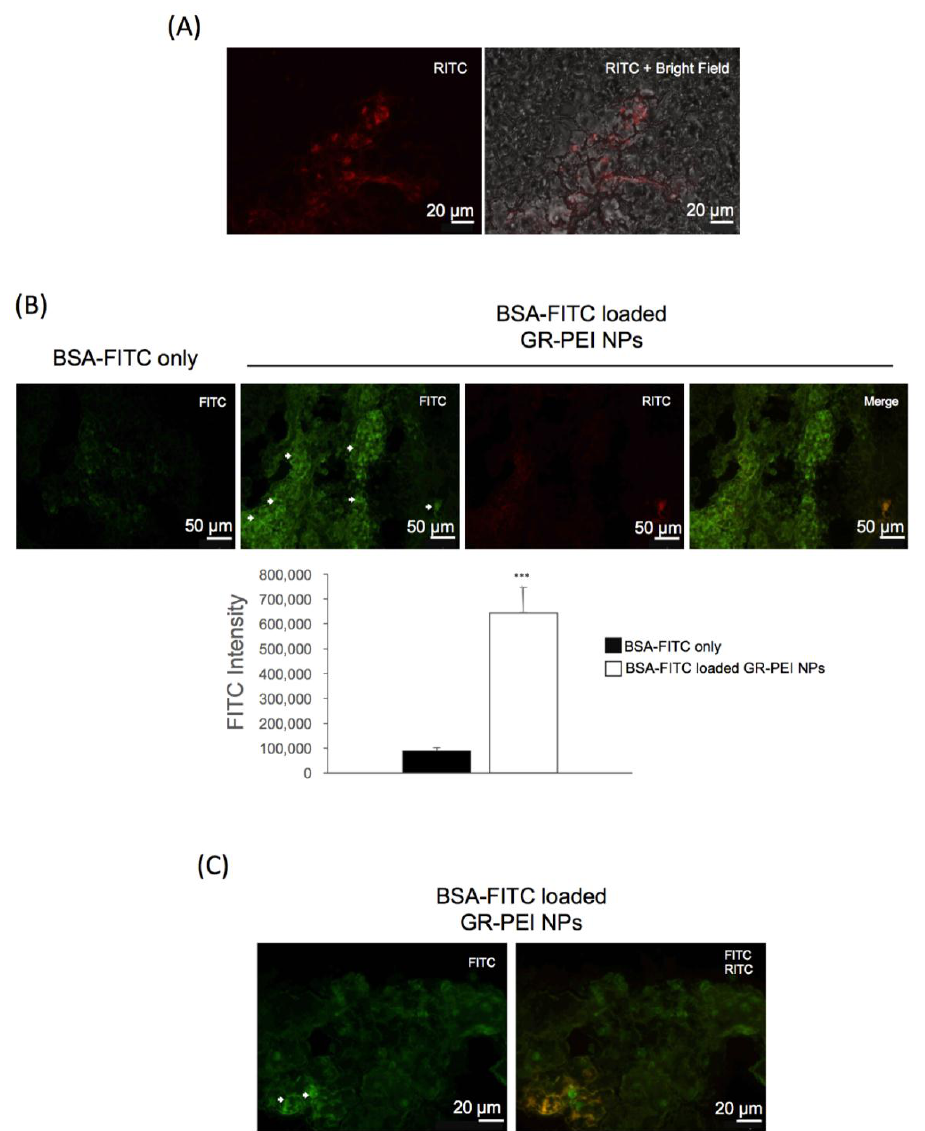
Figure 7. In vivo protein delivery by GR-PEI NPs. ( A ) 40 μg GR-PEI NPs were administrated in C26 tumor-bearing mouse by intra-tumor injection for 72 h ( n = 3). The RITC fluorescence in cryo-section (12 μm) of C26 solid tumor was observed by fluorescent microscope. The 40X images showed the cellular uptake of GR-PEI NPs in the tumor tissue. ( B ) BSA-FITC loaded GR-PEI NPs with weight ratio of 10:1 was used to evaluate the protein delivering efficiency of GR-PEI NPs in vivo. BSA-FITC loaded GR-PEI NPs were administrated in C26 cells tumor mouse model by intra-tumor injection for 72 h ( n = 3). Fluorescent microscopic image was used to evaluate the protein delivery in tumor tissues. The figures showed the intra-tumor accumulation of GR-PEI NPs and the cellular uptake of BSA-FITC. Free BSA-FITC delivery was showed in left panel. (Bar: 50 μm) Each bar represents the means of three determinations ±SD. *** p < 0.001 among the indicated groups compared with control group. ( C ) Intracellular delivery of BSA-FITC was shown as the spherical green fluorescent signals. (Bar: 20 μm).